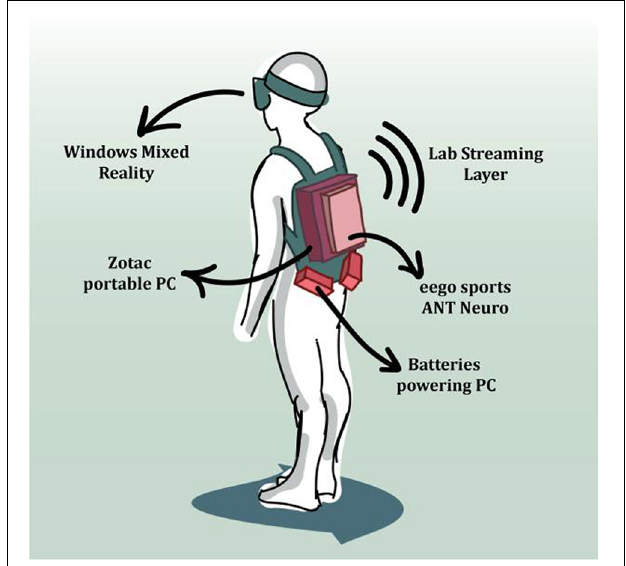
FIGURE 2 | The illustration depicts a MoBI setup using mobile EEG hardware combined with virtual reality and motion capture through the VR tracking system [from Djebbara et al. (2021); used with